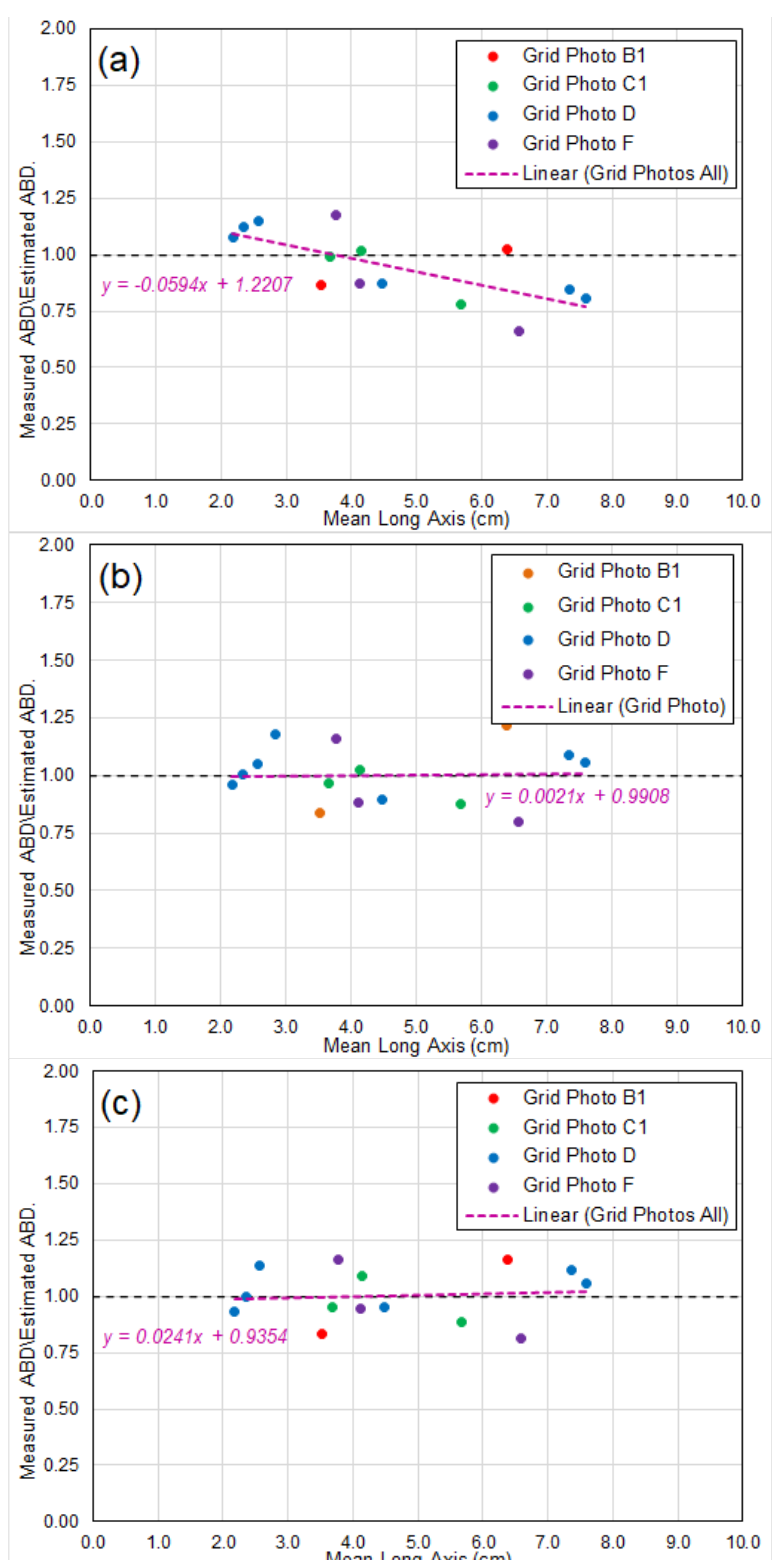
Figure 10. Comparisons of the measured Abundances and the predicted ones by the new empirical method with Dataset 1: ( a ) by empirical formula Equation (19); ( b ) by empirical formula Equation (19) with a linear adjustment; ( c ) by empirical formula Equation (25).